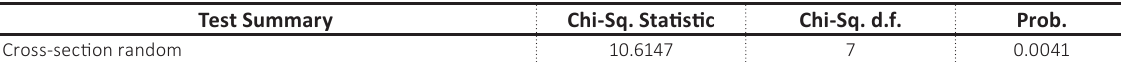
Table 6. Hausman test